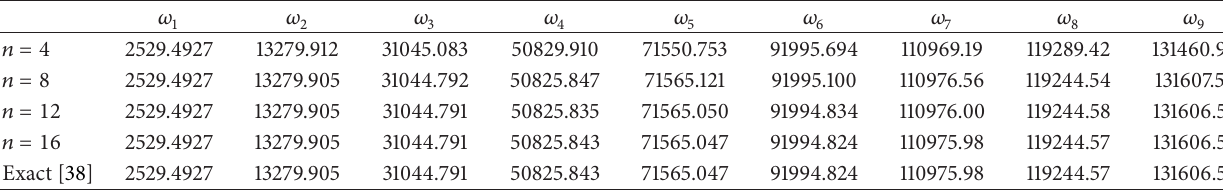
Table 2: Free vibration frequencies for clamped-free Timoshenko beam.